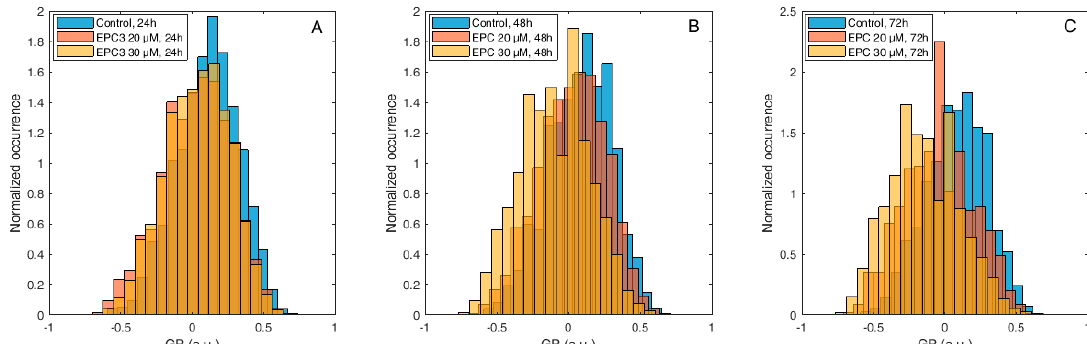
Figure 5. Laurdan GP values measured at the PM of MDA-MB-231 cells after EPC3 treatment. Normalized histograms of GP values measured in pixels belonging to the PM of MDA-MB-231 cells labeled with Laurdan. Cells were treated with 20 µM (orange bars) or 30 µM (yellow bars) EPC3. GP values measured in cells not treated with EPC3 are shown as blue bars. Fluorescence intensity values were acquired 24 h ( A ), 48 h ( B ), and 72 h ( C ) after the addition of EPC3. For each condition, GP values were pooled from ca. 50 ROIs selected at the PM of distinct cells, in two independent experiments. The total number of calculated GP values (and measured pixels) for each experimental condition was between ca. 10,000 and 40,000. Measurements were performed at RT. Representative images of treated cells and ROIs are shown in Figures S1 and S5.